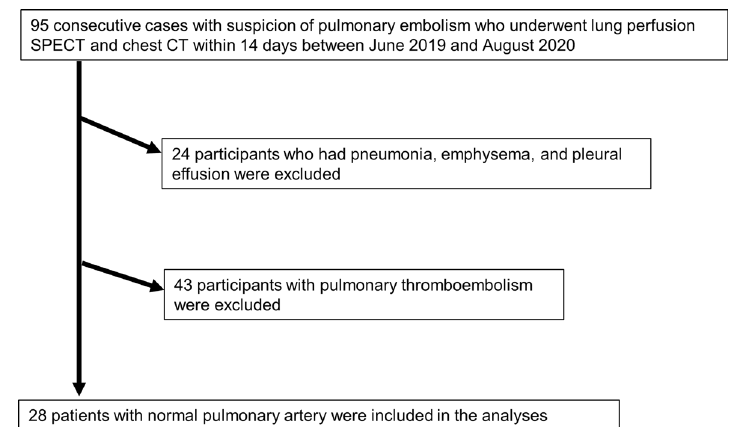
Fig. 1 Flowchart of patient inclusion and exclusion criteria in the study. Abbreviations: CT tomography; SPECT single-photon emission computed =